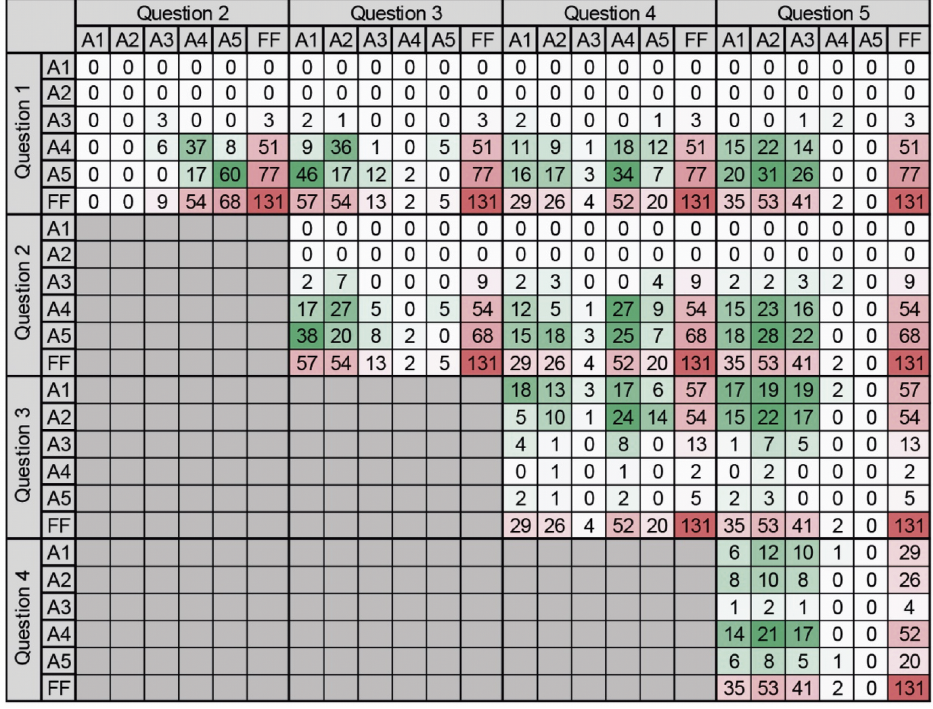
Figure 7. Matrix with the frequencies found in the polytomous variables of the survey. FF: fringe frequency